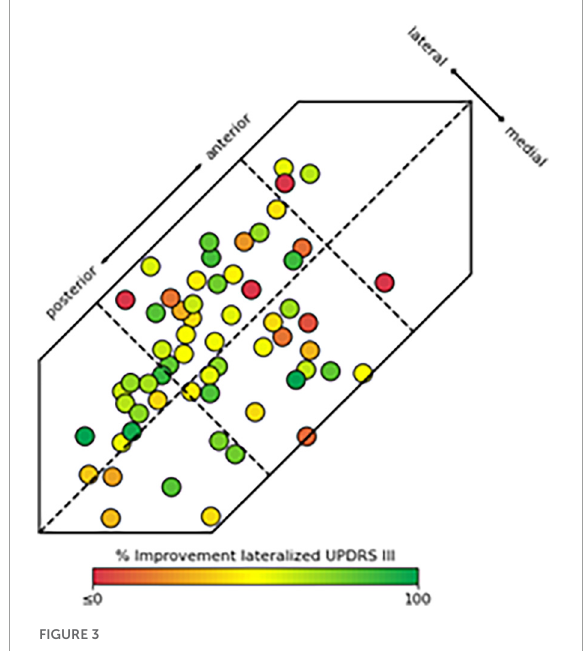
FIGURE3 Location of active contacts fully or partially within the subthalamic nucleus (STN) and their corresponding hemi-body motor improvement Unified Parkinson’s Disease Rating Scale (UPDRS% improvement). These data are represented as a heat map with lower or negative UPDRS improvement shown in red ( ≤ 0%) to greatest UPDRS improvement shown in bright green (100%). Contacts partially within the STN may appear fully within the STN in the figure as their locations were dorsal or ventral to the body of the STN region in the 3D